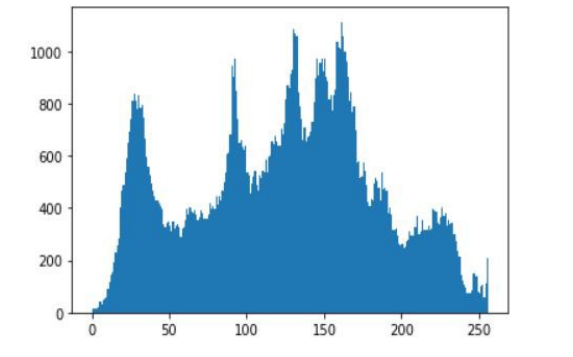
Figure 13. Histogram of encoded image of